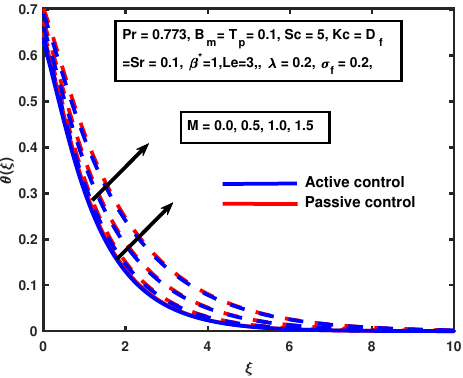
Figure 4. The impact of θ ( ξ ) on magnetic M .